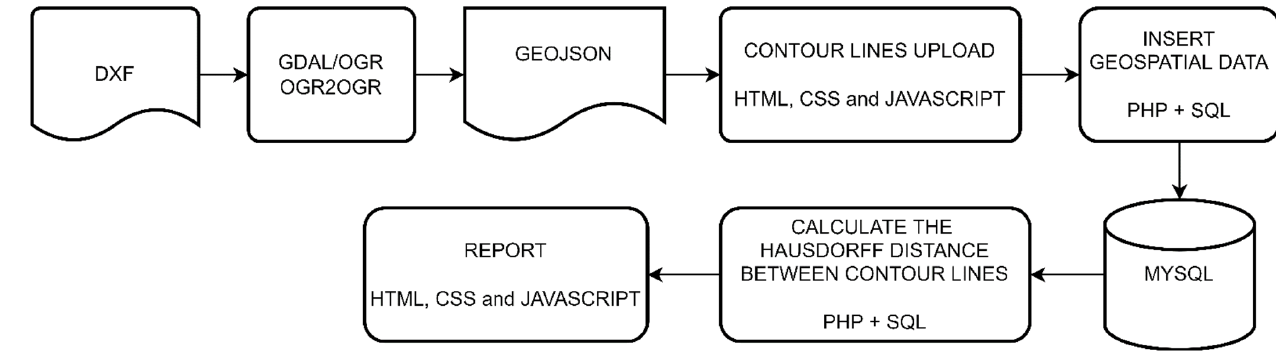
Figure 8. Flowchart of the Database System.